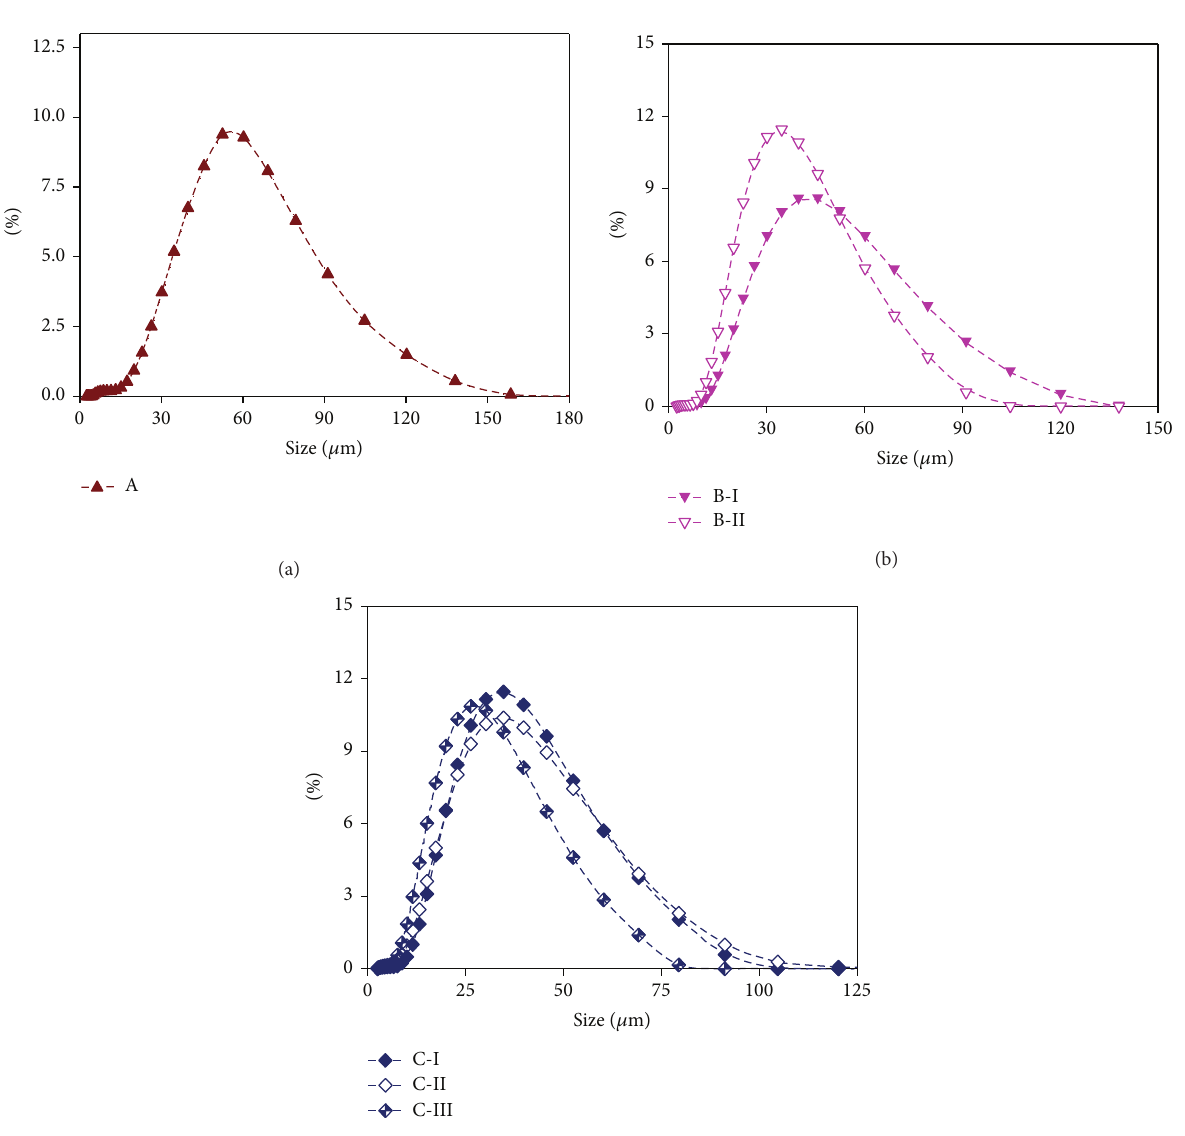
Figure 5: Variations of the size distribution with the Fe-As (V) samples in different dosing modes (pH